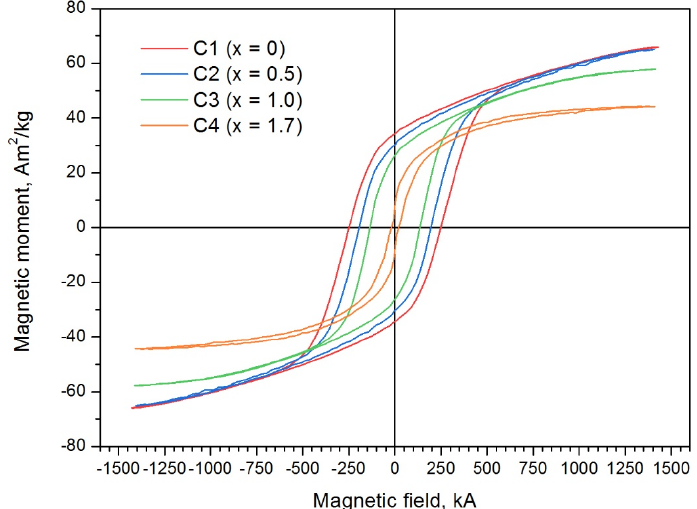
Figure 6. Hysteresis loops and magnetic properties of SrFe 12 − x In x O 19 samples obtained by the citrate method and annealed at 1200 ◦ C for 1